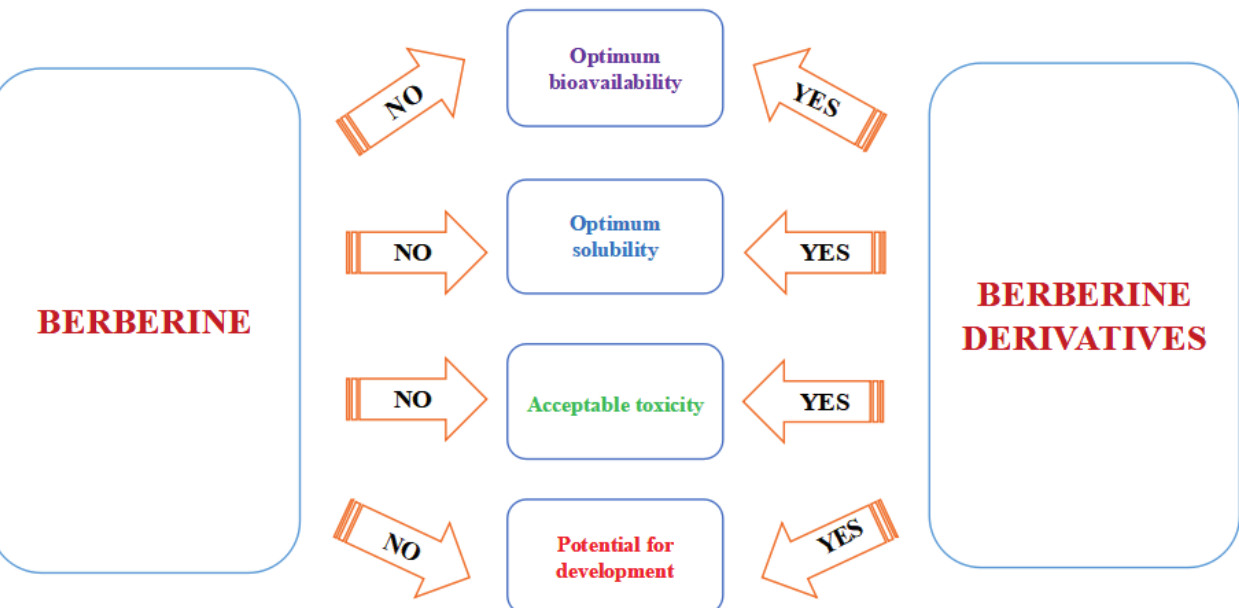
FIGURE 4 - A schematic presentation of BBR and its synthetic derivatives` potential for